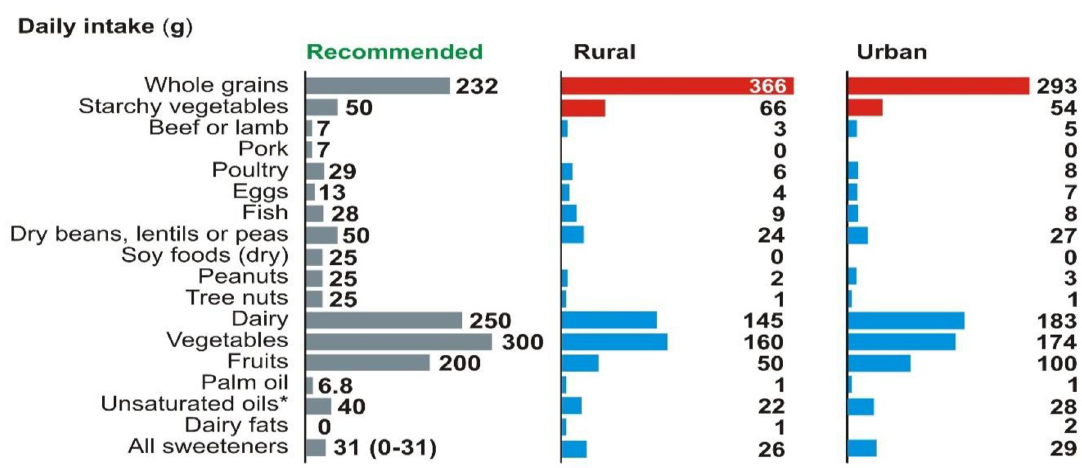
Fig 2. Daily food intake. (Source: EAT-Lancet commission) ( � olive, soybean, rapeseed, sunflower, and peanut oil) Note: Whole grains refer to rice, wheat and wheat products, millet and their products, cereal products refer to maida and other refined products from cereals, palm oil refers to vanaspati, unsaturated oils refer to sunflower, groundnut and refined vegetable oils, dairy fats refer to ghee and butter.